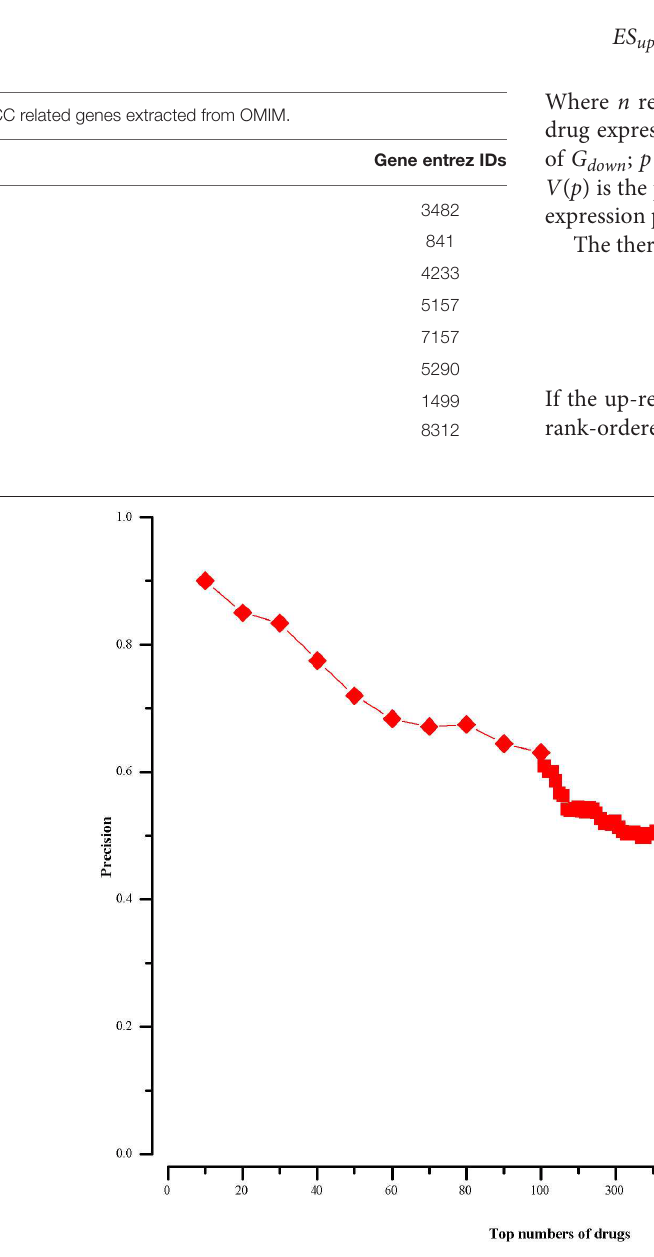
FIGURE 2 | The precision of our approach at different top-x